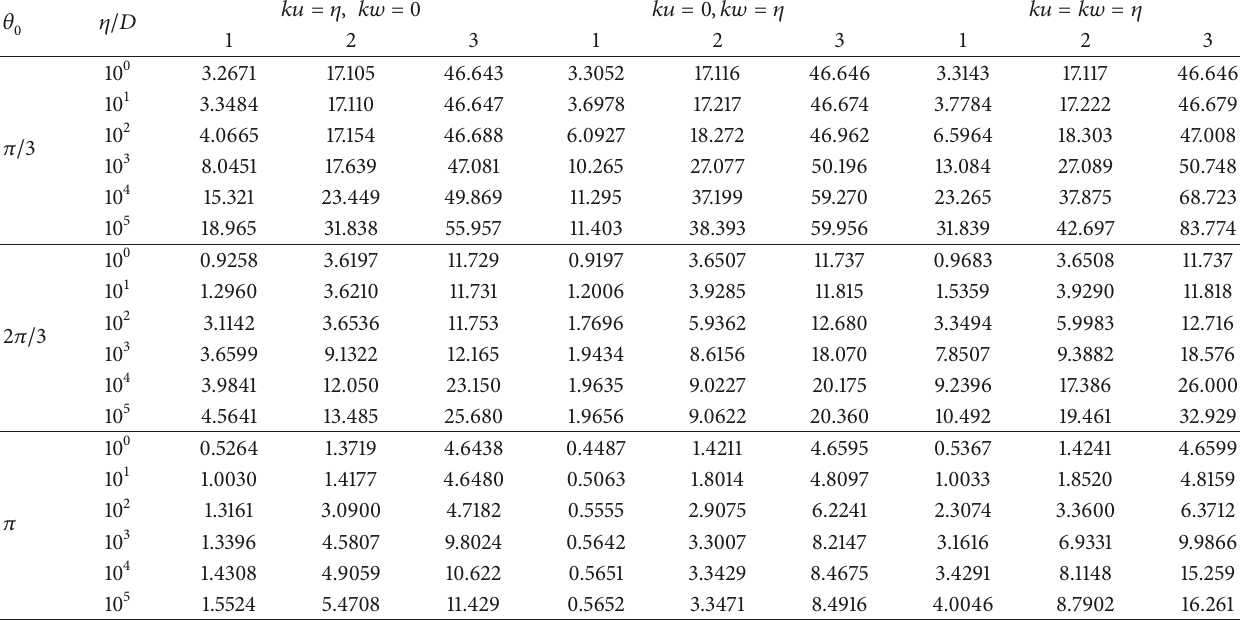
Table 7: Frequency parameters Ω for elastically supported circular beams with different span angles and restraint rigidities ( 𝑅 𝑚 = 1 m, ℎ/𝑅 = 0.1 𝑚